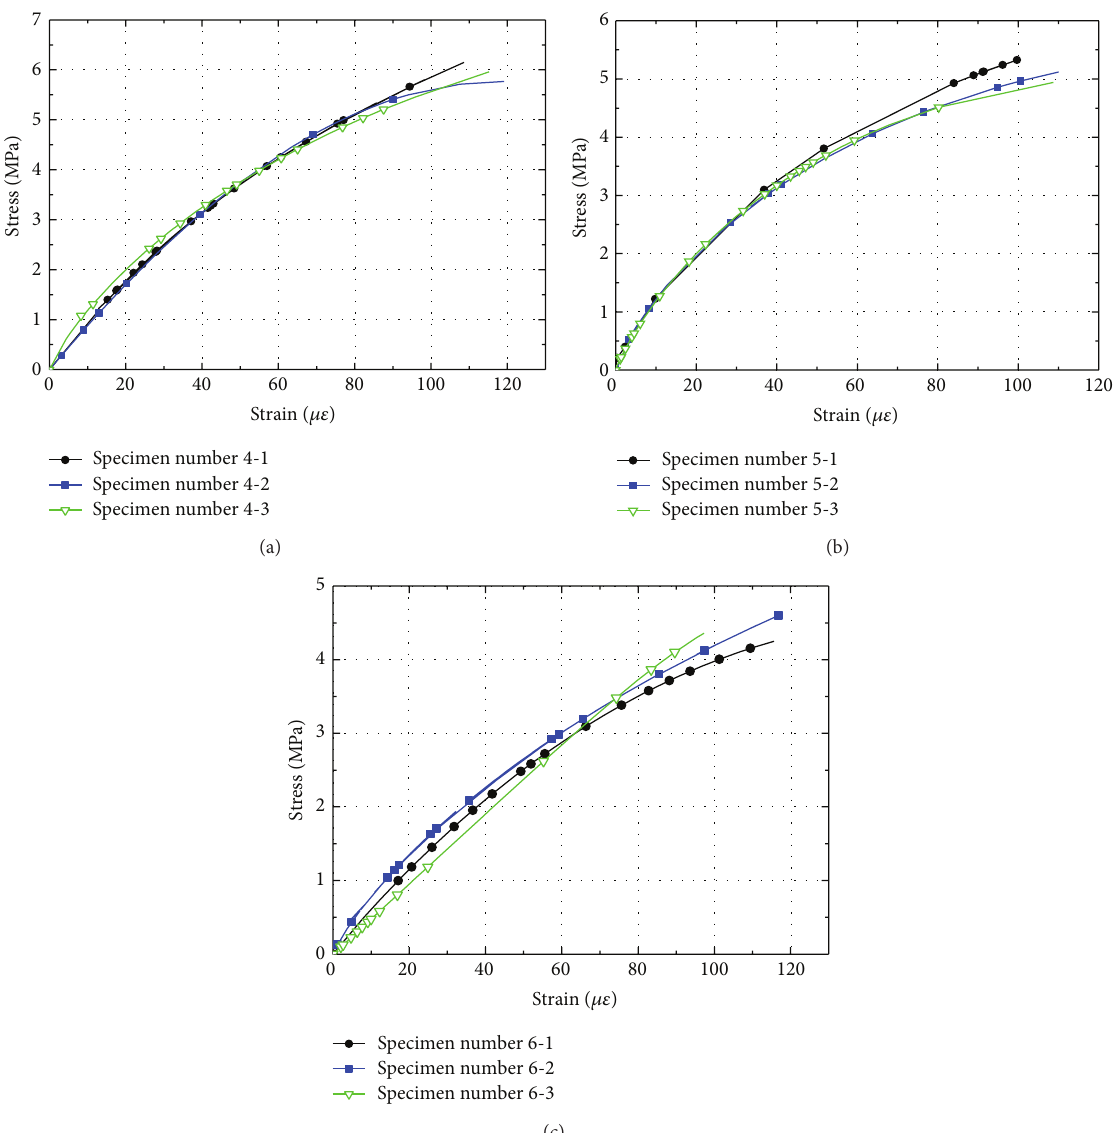
Figure 10: Influence of beam size on stress-strain curves of concrete: (a) beam depth 40 mm; (b) beam depth 100 mm; (c) beam depth 150